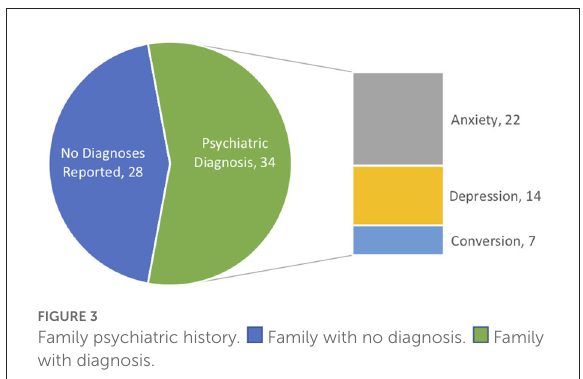
FIGURE3 Family psychiatric history. Family with no diagnosis. Family with